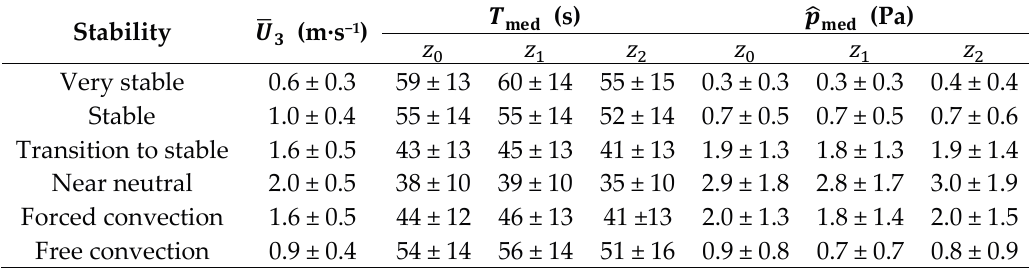
Table 3. Mean values for mean above-canopy wind speed (cid:1847)(cid:3365) (cid:2871) , dominant period in the medium frequency range (cid:1846) (cid:2923)(cid:2915)(cid:2914) and amplitudes in the medium frequency range (cid:1868)̂ (cid:2923)(cid:2915)(cid:2914) under different stability conditions.